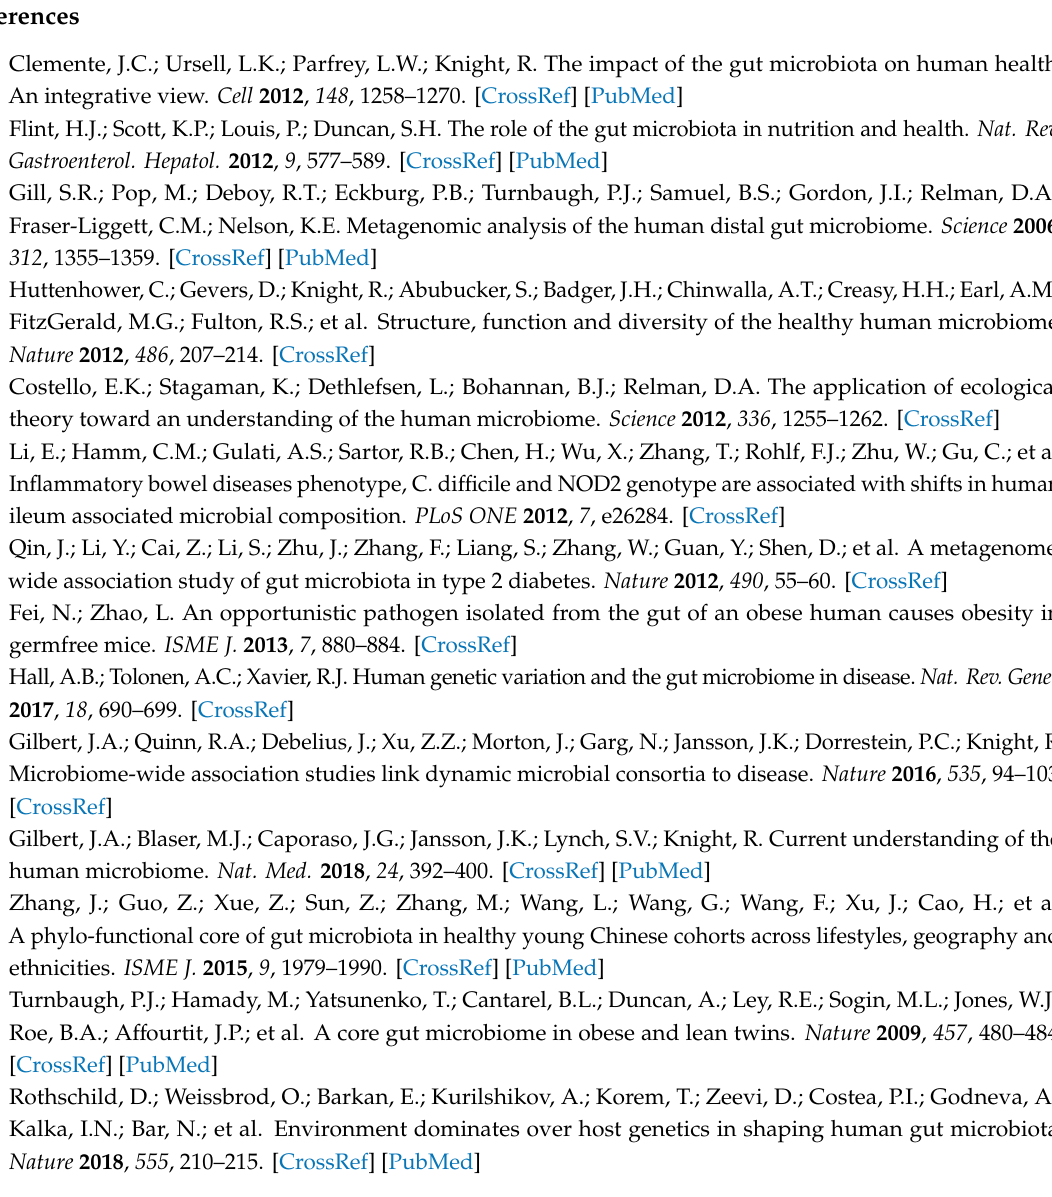
Figure S1: Venn diagram, Figure S2: Results of Variation decomposition, Figure S3: Results of ANOCOV, Figure S4: LEfSe, Table S1: Base information, Table S2: Redundancy analysis and forward selection component analysis, Table S3: Results of chi-square test among geographical location and ethnicity, Table S4: Results of Variation decomposition, ANOCOV, and PERMANOVA, Table S5: Tukey test for multiple comparisons, Table S6: Bacterial Biomarker, core genera, RDA TOP50, correlated